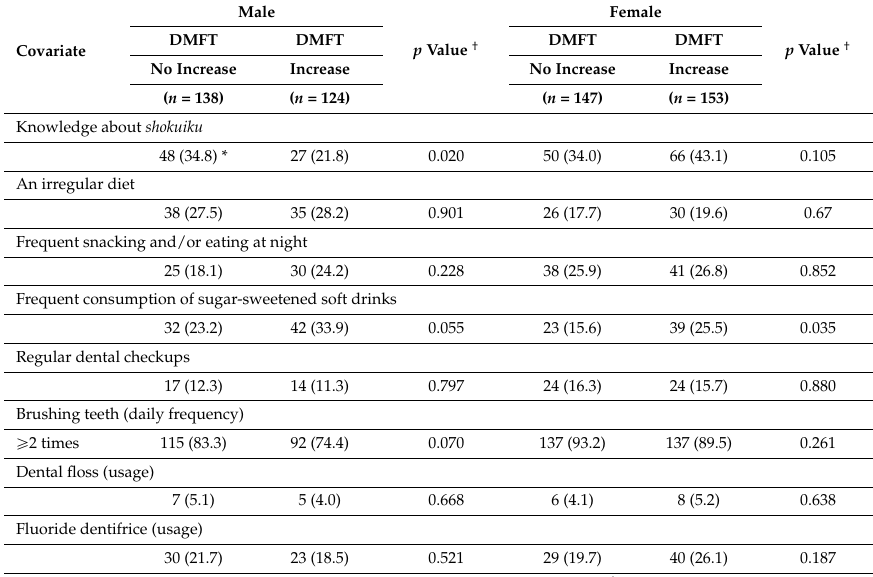
Table 3. Differences in knowledge about comprehensive food education ( shokuiku ), dietary habits, and oral health behaviors between the DMFT groups.